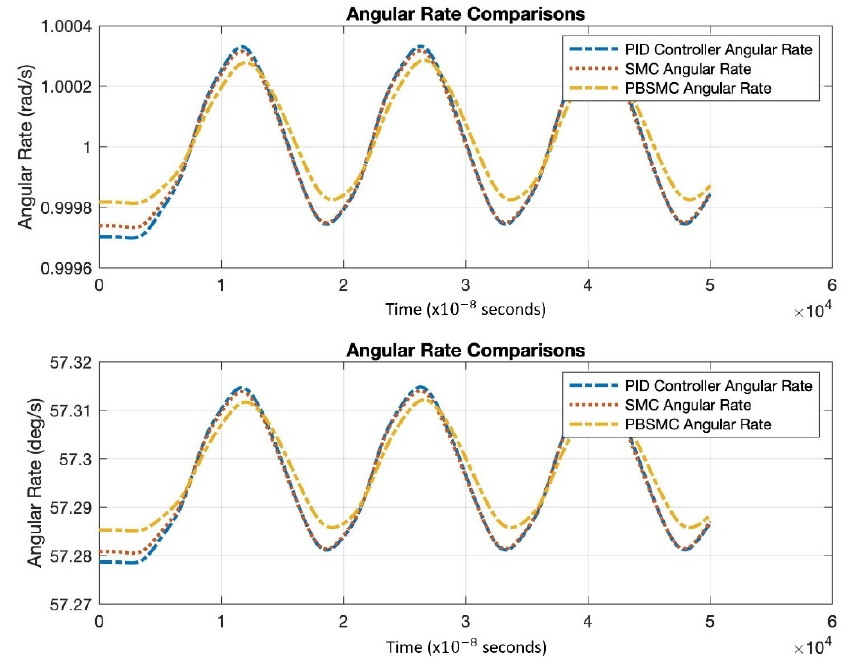
Figure 9. Angular Rate Output Comparison.